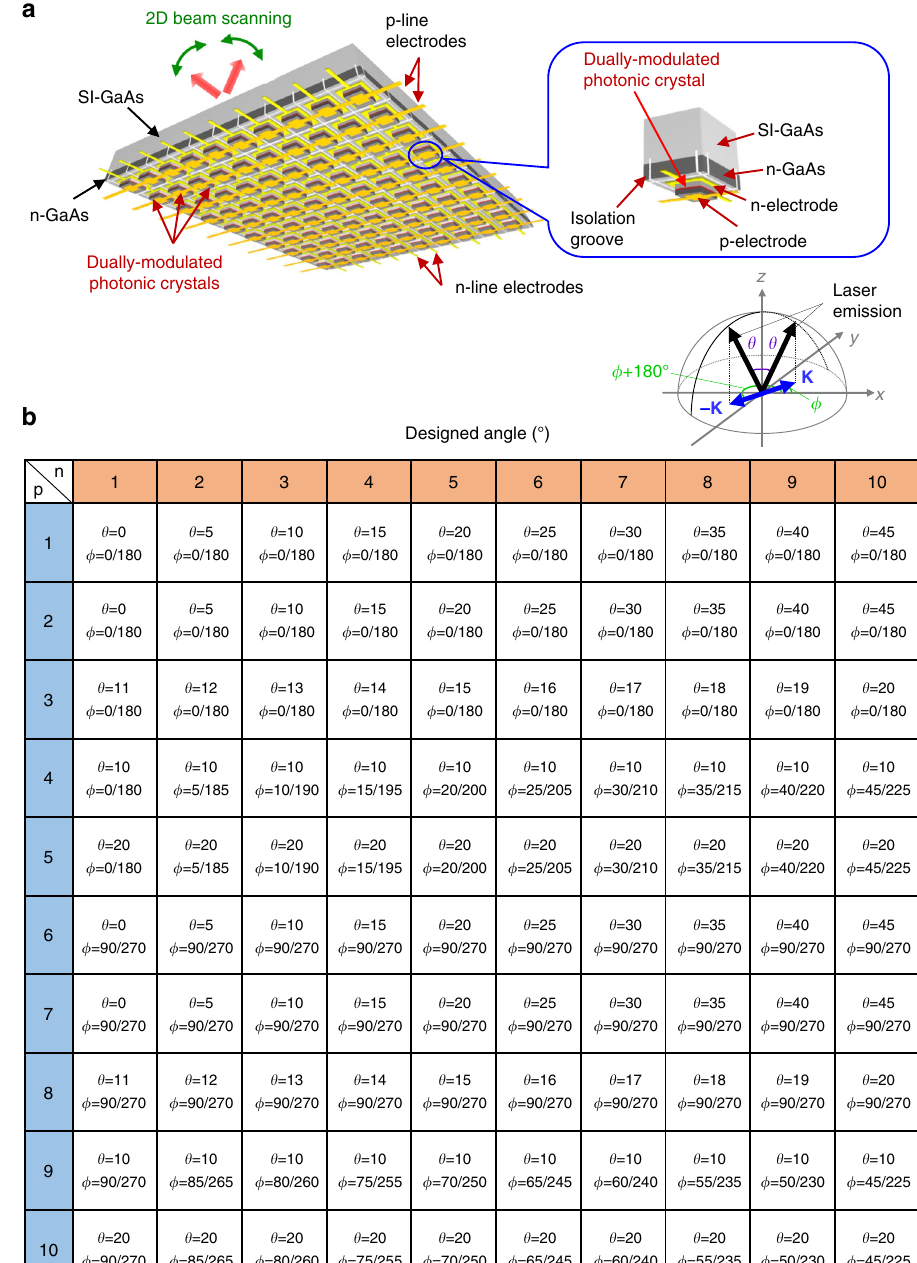
Fig. 4 Design of an on-chip dually modulated photonic-crystal laser array. a Schematic diagram of a dually modulated photonic-crystal laser array. Each lasing area is electrically isolated by isolation grooves. Lasers at each intersection of p- and n-line electrodes can be selectively operated by driving the corresponding line electrodes. b Designed angles ( θ and ϕ ) of 100 laser elements (10 × 10) in the array. The emission angle de fi nitions are shown in the inset.